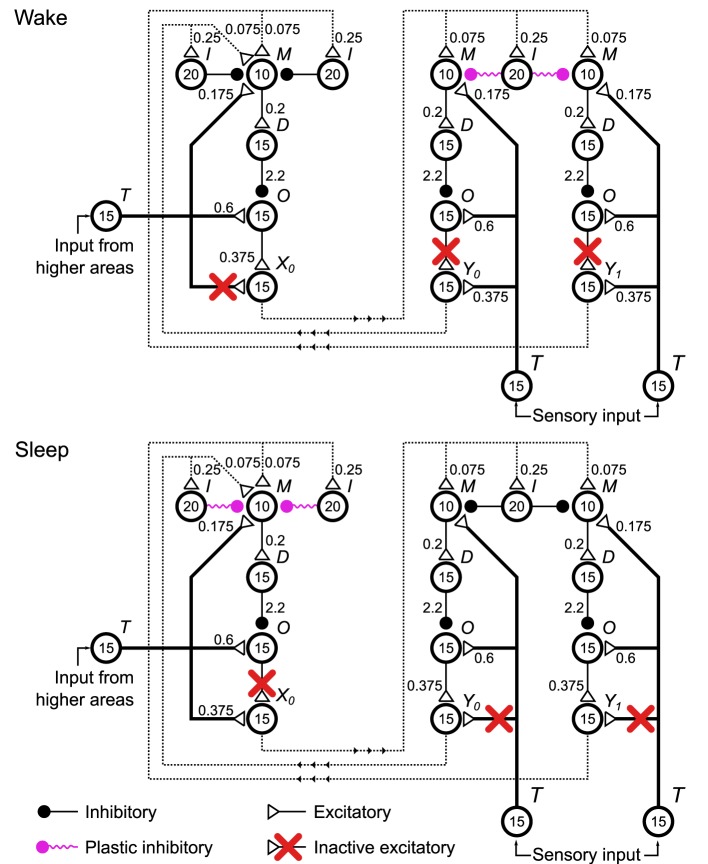
Configurations of the spiking neuronal network implementation of the Helmholtz Machine during the wake and sleep phases of learning. Four delta rule networks (Figure 2A), referred to as units within the context of this network, are wired up together to form the Helmholtz Machine, with two handling the sensory layer computation and two handling the hidden layer computation (only one is shown in this figure for clarity). See Figure 2 caption for explanation of the symbols used. To support the two phases of the wake-sleep algorithm some connections (red crosses) are inactivated to control what determines the firing rate of the output pools of each unit (pools X0, X1, Y0 in this figure). In the wake phase (top) the outputs of the sensory units are determined by the sensory input, while the outputs of the hidden units are determined by the firing rates and the corresponding connection strengths of the outputs of the sensory units. In the sleep phase the outputs of the sensory units are determined by the firing rates and the corresponding connection strengths of the outputs of the hidden units, while the outputs of the hidden units are driven by the input from higher areas. Additionally, in accordance with the wake-sleep algorithm, the plastic connection strengths to the sensory units only get modified during the wake phase, and vice versa for the connection strengths to the hidden units. The non-specific external inputs within each unit are not shown. Also not shown are plastic inputs onto the pool M of each unit that implement the bias activity and weights. These are modeled as a Poisson spike train with rate rb = 25 Hz. These plastic inputs form the same type of plastic inhibitory synapse as all the other plastic connections shown on the figure.